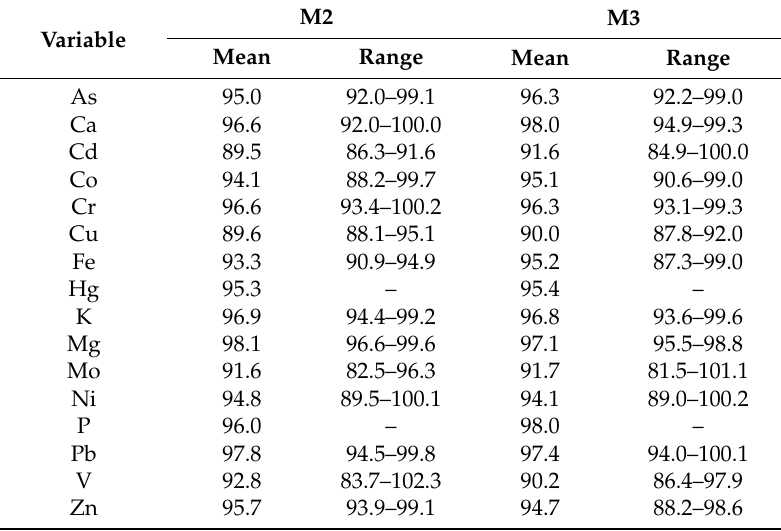
Table A1. Percentage recoveries of the elements measured in